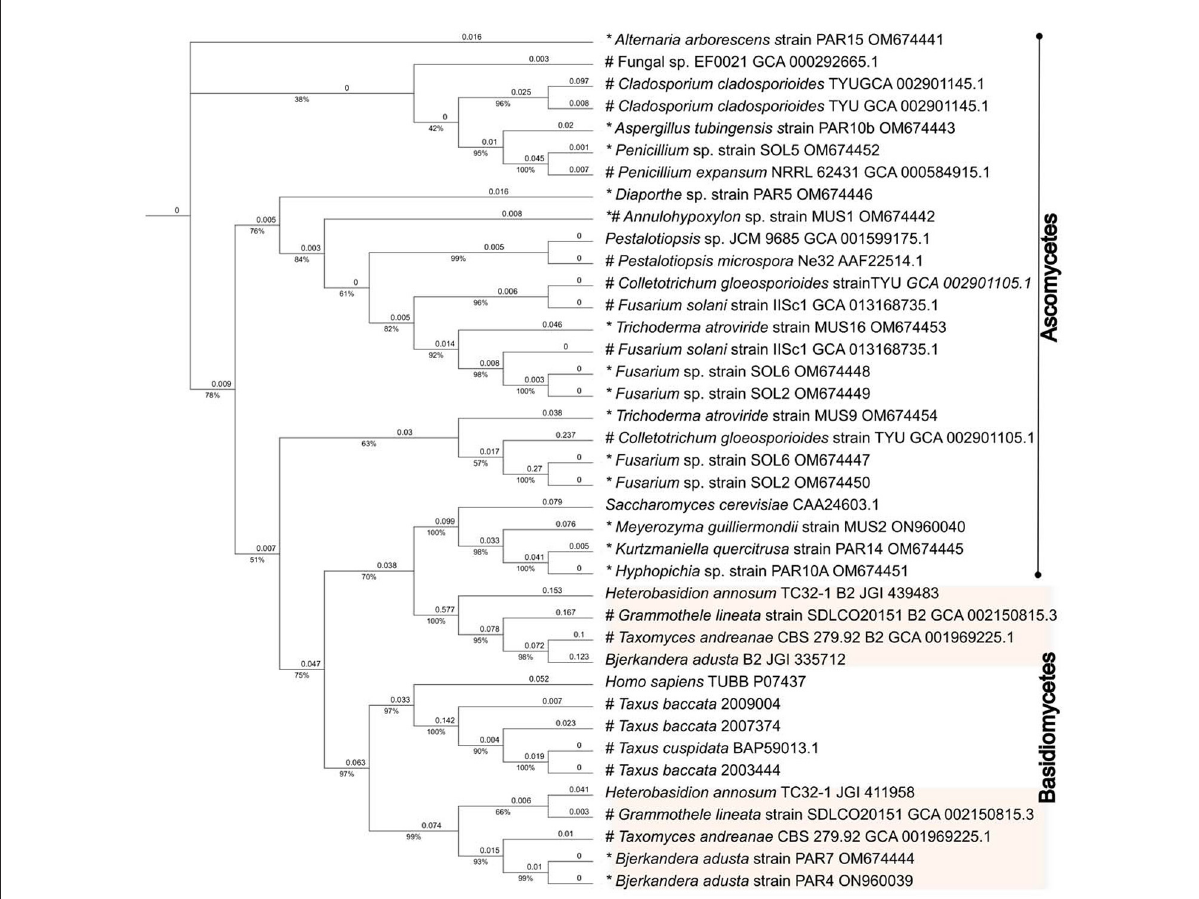
FIGURE4 Evolutionary analysis of the β -tubulins proteins. The evolutionary history was inferred by using the IQ-TREE web server (Trifinopoulos et al., 2016) and edited using the Interactive Tree Of Life (iTOL) online tool (Letunic and Bork, 2021). The analysis was done using the default parameters. The analysis only included the 428 amino acids that have been implicated in the paclitaxel- β -tubulin interaction. In addition, GenBank protein sequences from fungal endophytes isolated from Taxus spp. or from fungi deemed able to synthesize paclitaxel were included in the analysis. For comparison, the human and Taxus β -tubulins protein sequences were also included. The phylogenetic tree generated formed branches that clearly allocated the β -tubulins along the Ascomycetes and Basidiomycetes divisions. The β -tubulins from Taxus spp. and the most highly expressed human β -tubulin (P07437) clustered together in a separate branch with the Basidiomycete β -tubulins. The Taxomyces andreanae β 1 -tubulin also clustered in this group, and the β 2 tubulin clustered with the rest of the β 2 tubulin from Basidiomycete fungi in a separate clade. This would suggest that T. andreanae CBS 279.92 belongs in the phylum Basidiomycota, rather than Ascomycota as originally proposed. An asterisk (*) indicates the fungi isolated by Gauchan et al. (2021), which were used in this study, and the pound sign (#) indicates plant/fungus that can synthesize paclitaxel. JGI numbers refer to protein sequence number available from the Joint Genome Institute (https://